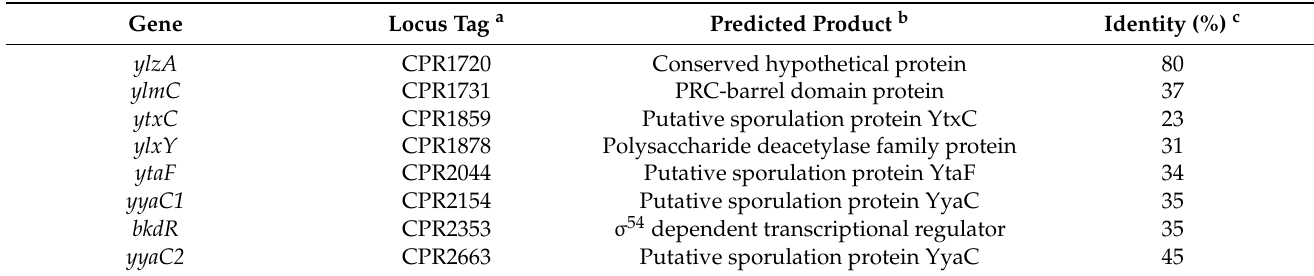
Table 1. Putative sporulation genes in C. perfringens strain SM101.P